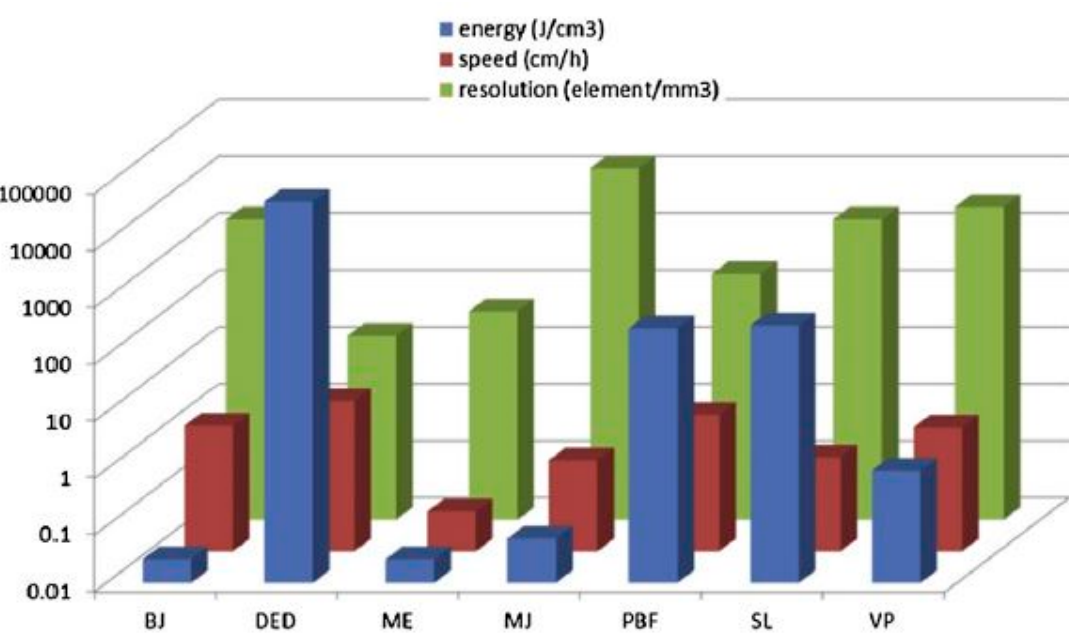
Figure 10. Energy used, speed and resolution of fabrication in different AM techniques. Reproduced with permission from [154]. Copyright Elsevier, 2017.